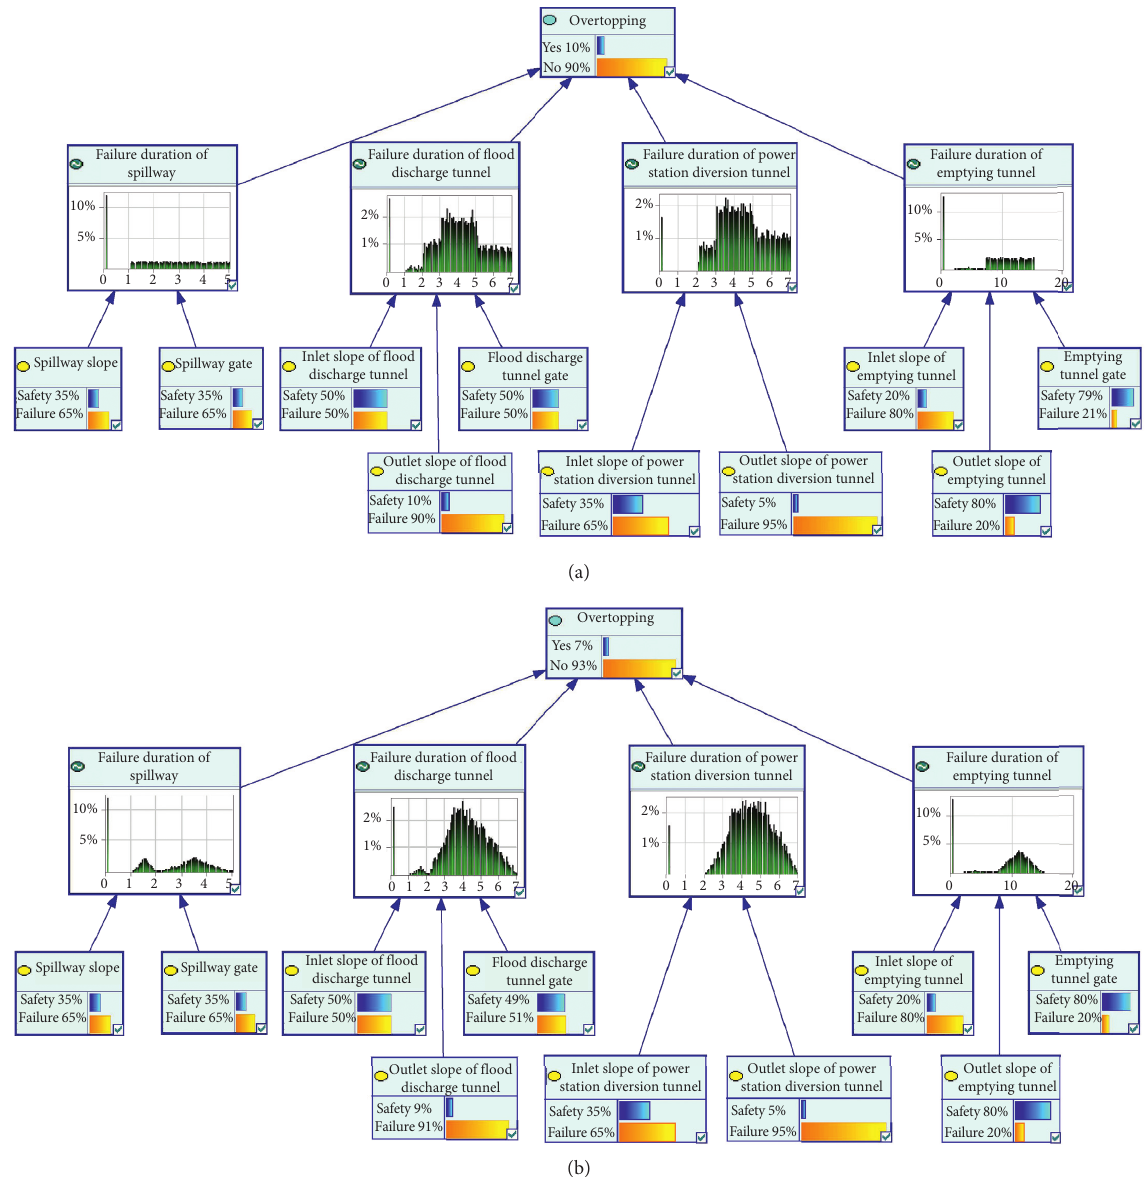
Figure 11: Results of overtopping risk analysis for different probability distributions of failure duration of release structure related to a landslide or gate failure: (a) case I, uniformly distributed failure duration, and (b) case II, triangularly distributed failure